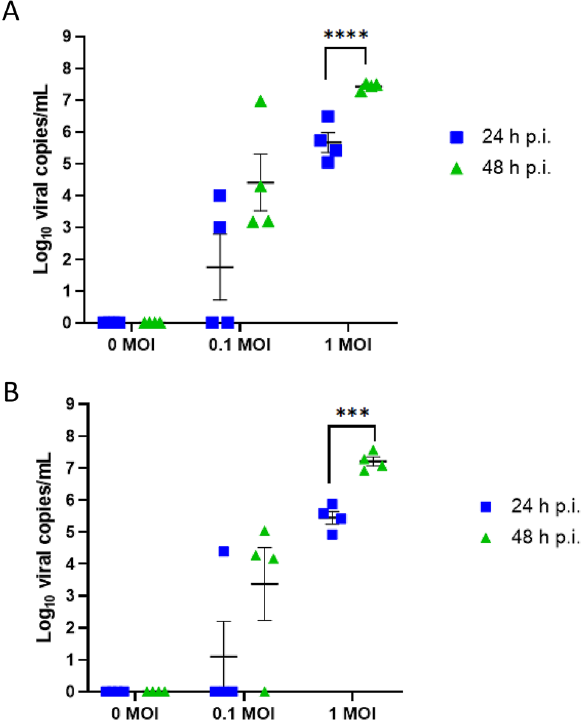
Figure 5. Infection kinetics of IAV-inoculated PREDICT96-ALI airway tissue. RT-qPCR analyses for viral copies in the apical wash of PREDICT96-ALI airway tissue at 24 and 48 h p.i. ( A ) PREDICT96-ALI airway tissue inoculated with A/California/04/09 H1N1 and monitored for an increase in viral load at 24 h intervals with a statistically significant increase in viral copies at 48 h p.i. compared to 24 h p.i. for the MOI 1 condition. ( B ) PREDICT96-ALI airway tissue inoculated with A/Hong Kong/8/68 H3N2 and monitored for an increase in viral load at 24 h intervals with a statistically significant increase in viral copies at 48 h p.i. compared to 24 h p.i. for the MOI 1 condition. Statistical significance: ***p ≤ 0.001 and ****p ≤ 0.0001. N = 2 independent experiments with data presented from one representative experiment. Per experiment, N = 3–4 tissue replicates per donor, time-point and condition. Donor B showcased as representative. Replicates that did not meet the minimum signal intensity after 45 PCR cycles are displayed along the x-axis.